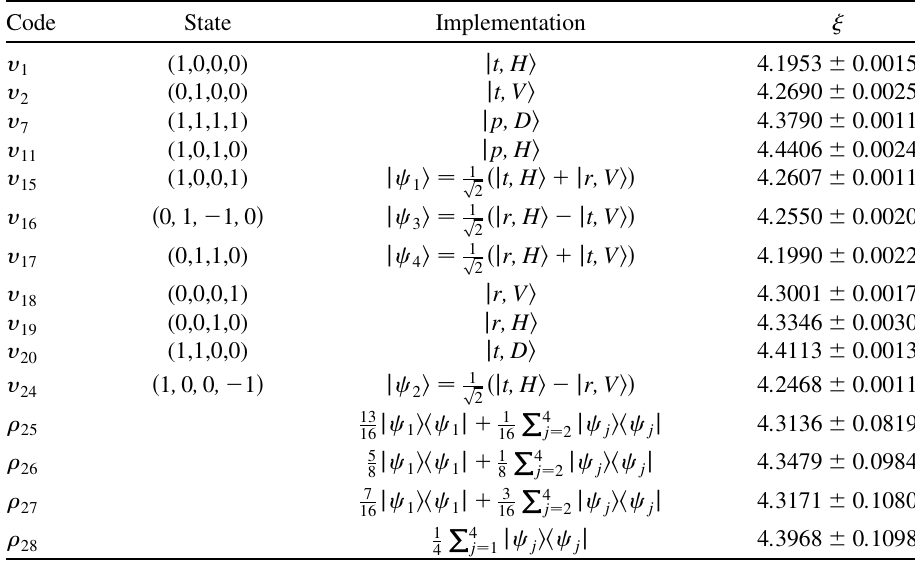
TABLE II. Experimental results for (cid:5) for 15 quantum states. Notation for this Table includes H iþj V i ffiffi j p i ¼ j t iþj r i ffiffi p and j D i ¼ j p . The errors in the results of (cid:5) are deduced from the standard 2 2 deviation of 50 samples in the 10-s time period. [See the Supplemental Material [39] for all the experimental values of P ð abc j xyz Þ for the 15